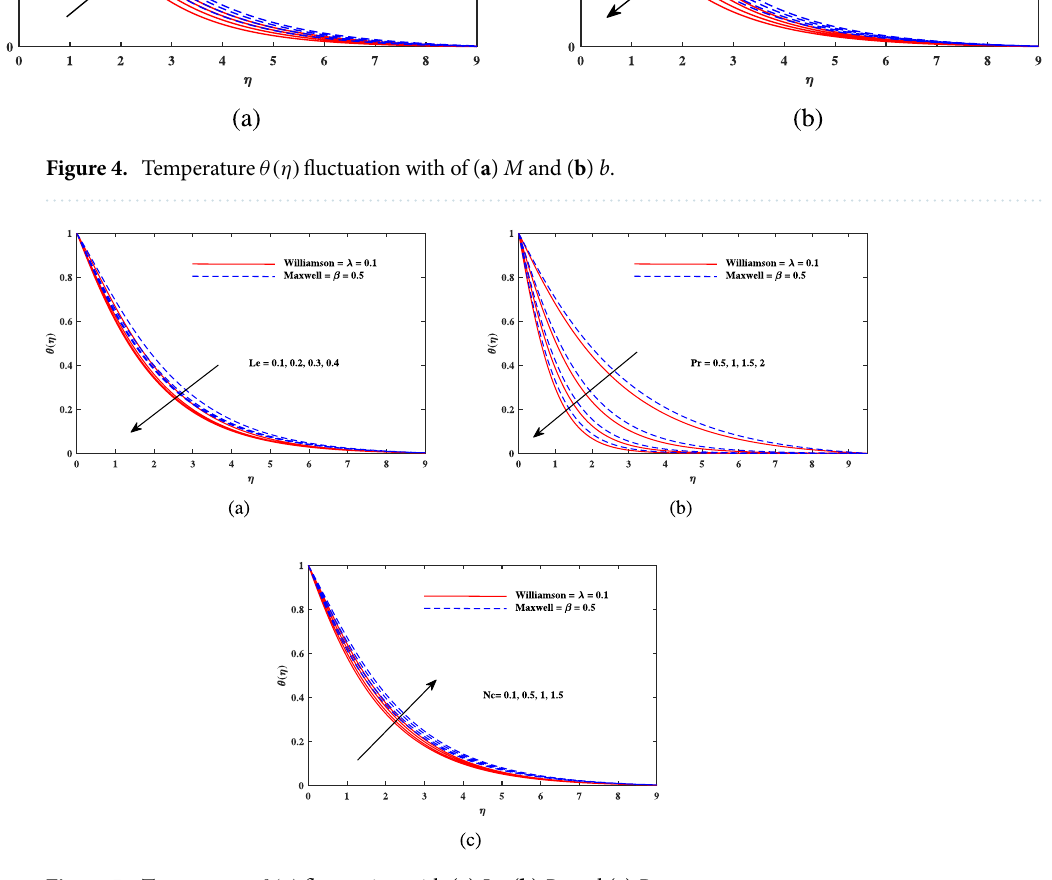
Figure 5. Temperature θ(η) fluctuation with ( a ) Le , ( b ) Pr and ( c ) Pr .